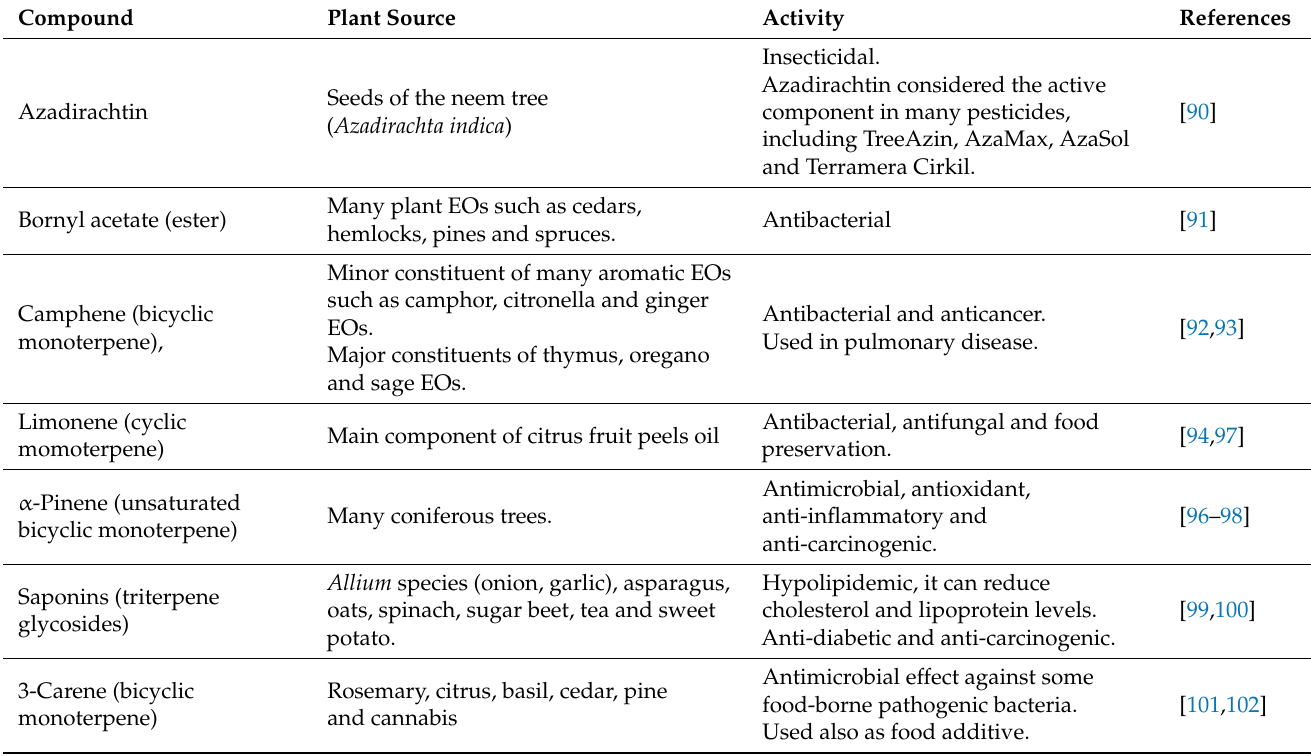
Table 1. Some common plant